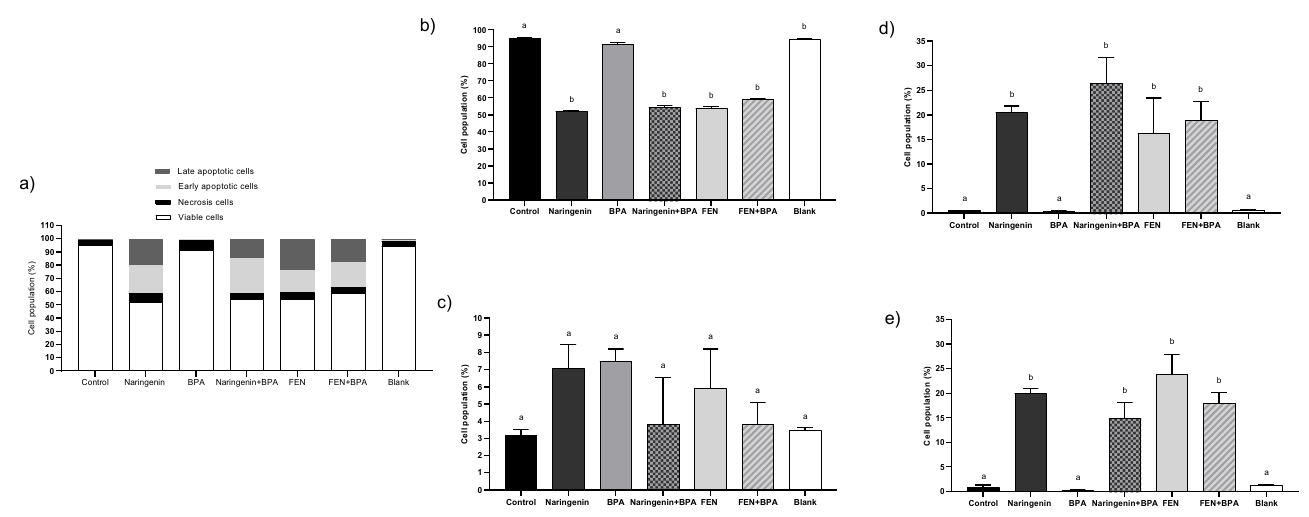
Figure 4. Flow cytometry analysis with Annexin V. HT-29 cells were incubated 24 h with the treatments: 250 µM naringenin, 4.4 µM BPA, 37% FEN, co-treatment naringenin + BPA or co-treatment FEN + BPA, and blank of fermentation (10%) on. ( a ) All cells ( b ) Viable cells, ( c ) Necrosis cells, ( d ) Early apoptotic cells, ( e ) Late apoptotic cells. The experimental data are expressed as the mean value ± SD of the two independent experiments with two replicates each one. Letters indicate statistical difference ( p < 0.05).